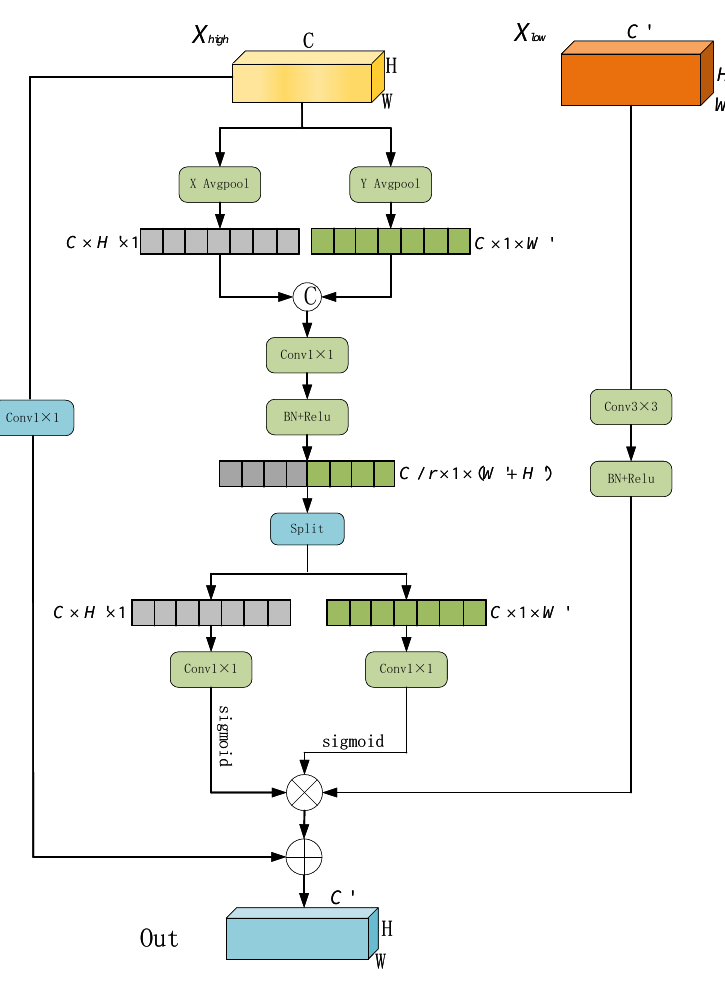
Figure 3. Multi-scale feature fusion module structure